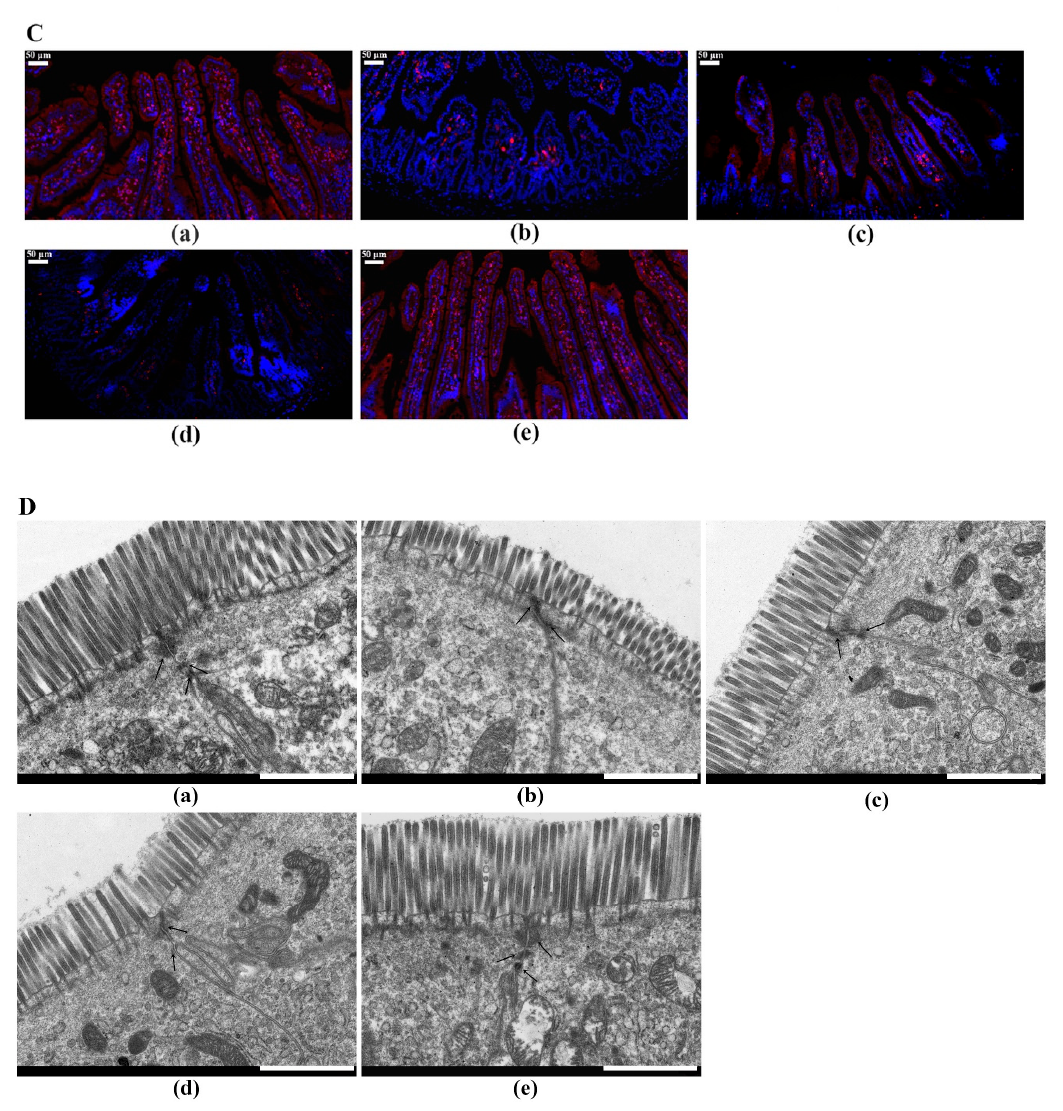
Figure 6. The protective effects of LTP on the intestinal barrier. ( A ) TEER values of mouse jejunum epithelium were determined ex vivo in Ussing chambers. ( B ) Expression of TJ markers (ZO-1 and Occludin) were monitored by Western blotting. ( C ) Jejunum sections were stained for ZO-1 (red) and nuclei (blue) and analysed by immunofluorescence microscopy. Bar, 50 µ m. ( C - a ) Control, ( C - b ) LPS, ( C - c ) LL-37 + LPS, ( C - d ) TP5 + LPS, and ( C - e ) LTP + LPS. ( D ) The TJ structure of jejunal epithelium was confirmed by TEM. Bar, 2 μ m. ( D - a ) control, ( D - b ) LPS, ( D - c ) LL-37 + LPS, ( D - d ) TP5 + LPS, and ( D - e ) LTP + LPS; the wider intervals and more blurred desmosomes (black arrowheads) between the intestinal epithelial cells are indicated. Data are given as the mean value ± standard error from at least three biological replicates. *: p ≤ 0.05, **: p ≤ 0.01.